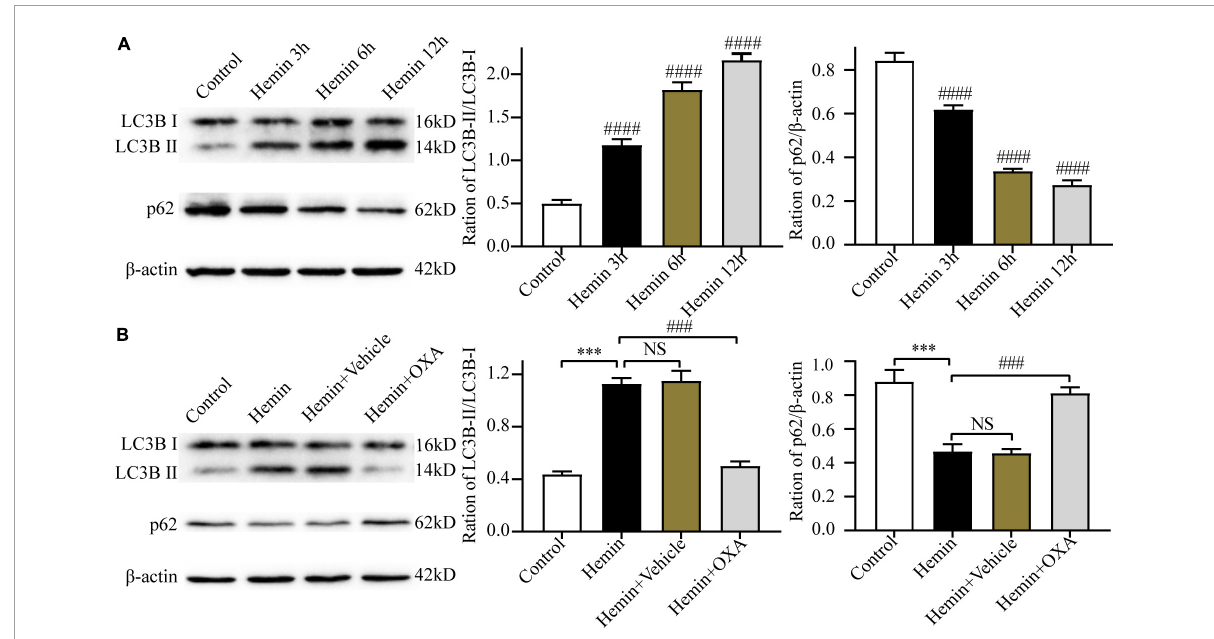
FIGURE5 Hemin-induced injury triggers autophagy, and OXA inhibits autophagy. (A) The expression changes of autophagy-related proteins (LC3B and p62) at different time points after hemin-induced injury. (B) Western blot images of LC3B and p62 and results of quantitative analysis in each group of PC12 cells. ∗∗∗ p < 0.001 and #### p < 0.0001 vs. the control group; NS, non-significant different compared to the control group. ### p < 0.001 vs. the hemin